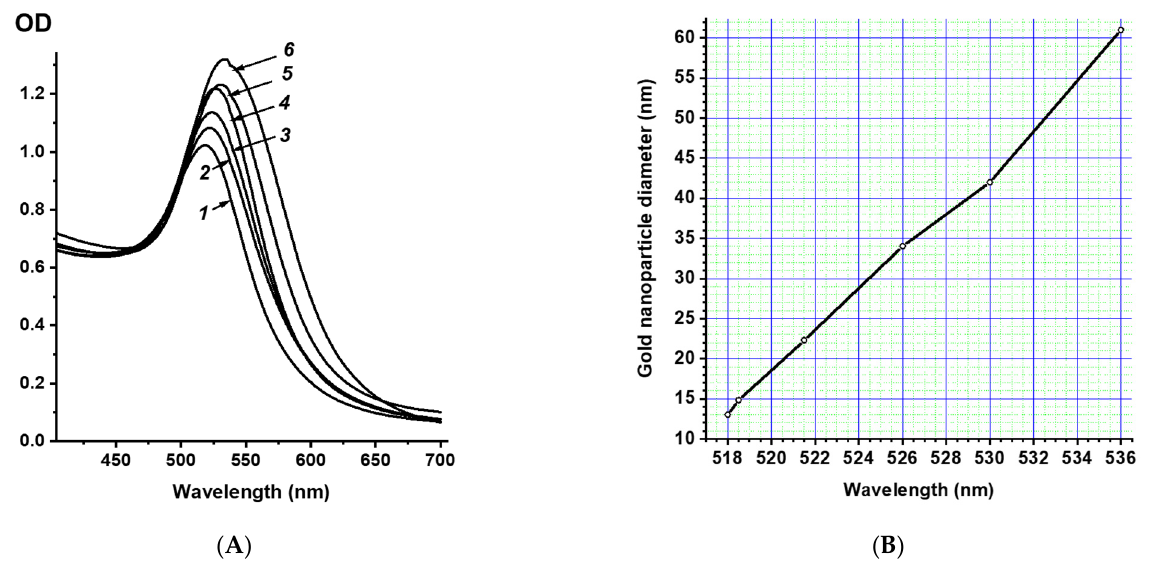
Figure 3. Absorption spectra ( A ) of the preparations GNP1 ( 1 ), GNP2 ( 2 ), GNP3 ( 3 ), GNP4 ( 4 ), GNP5 ( 5 ), and GNP6 ( 6 ) and the calibration dependence ( B ) of the maximum of the absorption spectrum on the diameter of the GNP.